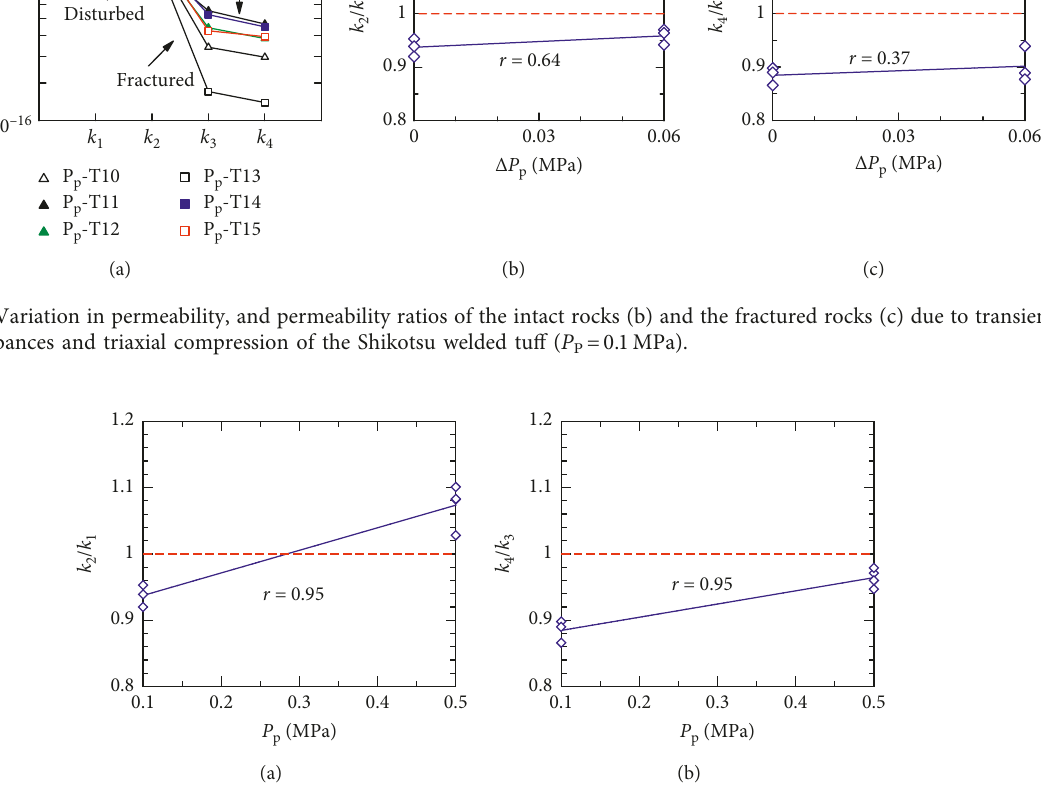
Figure 22: Effect of pore pressure on permeability ratios without stress disturbances. (a) Intact; (b)